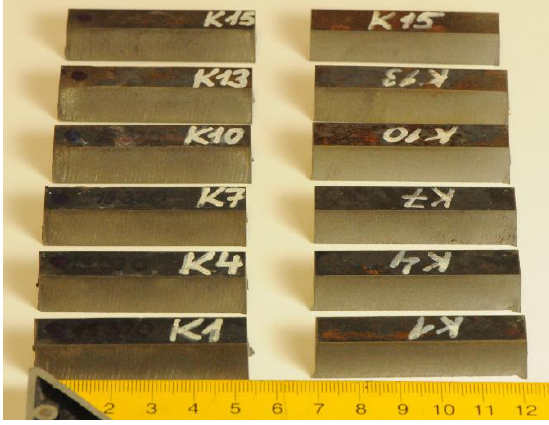
Figure 2. Samples used for analysis of material structure impact on declination angle (see [24]).